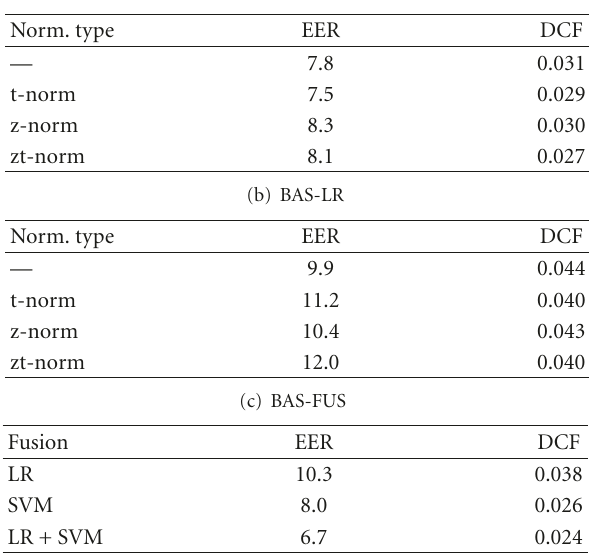
Table 2: Speaker verification results of the baseline (BAS) systems. The EER and DCF figures for (a) the SVM and (b) LR decision criteria as well as (c) their fusion are given.